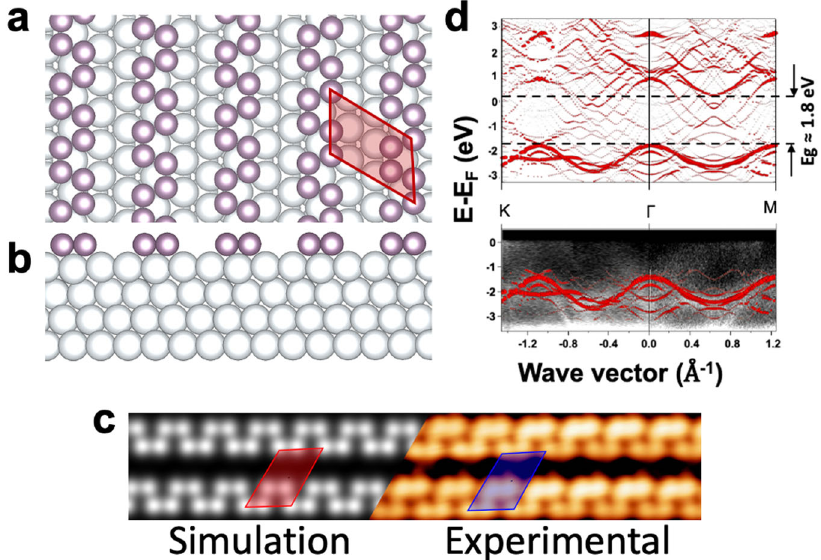
Fig. 4 Model of PNR structure from DFT calculations. a Top view showing the armchair PNR structure. P atoms are in purple, Ag atoms in gray. The 2 × 3 unit cell is indicated by the red parallelepiped. b Side view showing the atoms of the P chains lying fl at on the Ag substrate. c Simulated (left) and experimental (right) STM images. d (upper panel) The calculated DFT band structure of the whole 4P/(2 × 3)-Ag(111) surface along the K – Γ – M path of the (1 × 1)-Ag(111) surface using 160 k-points. d (lower panel) The superposition of the experimental and the calculated ARPES shows an excellent